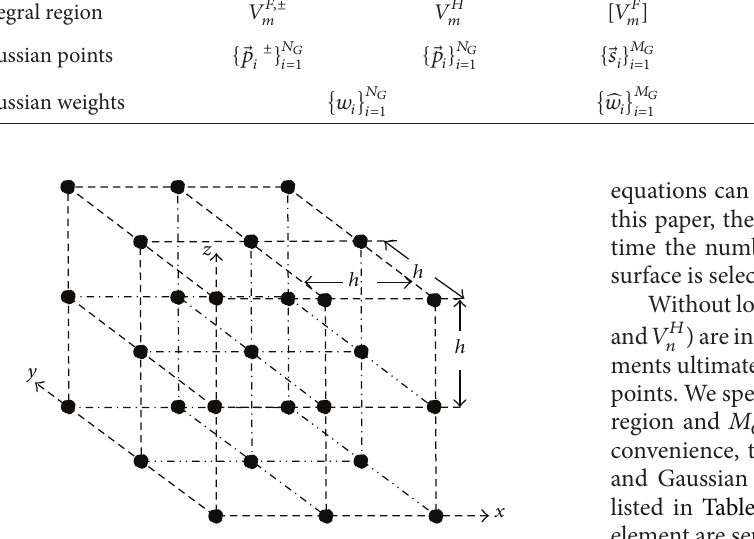
Figure 2: An expansion box of order 2.